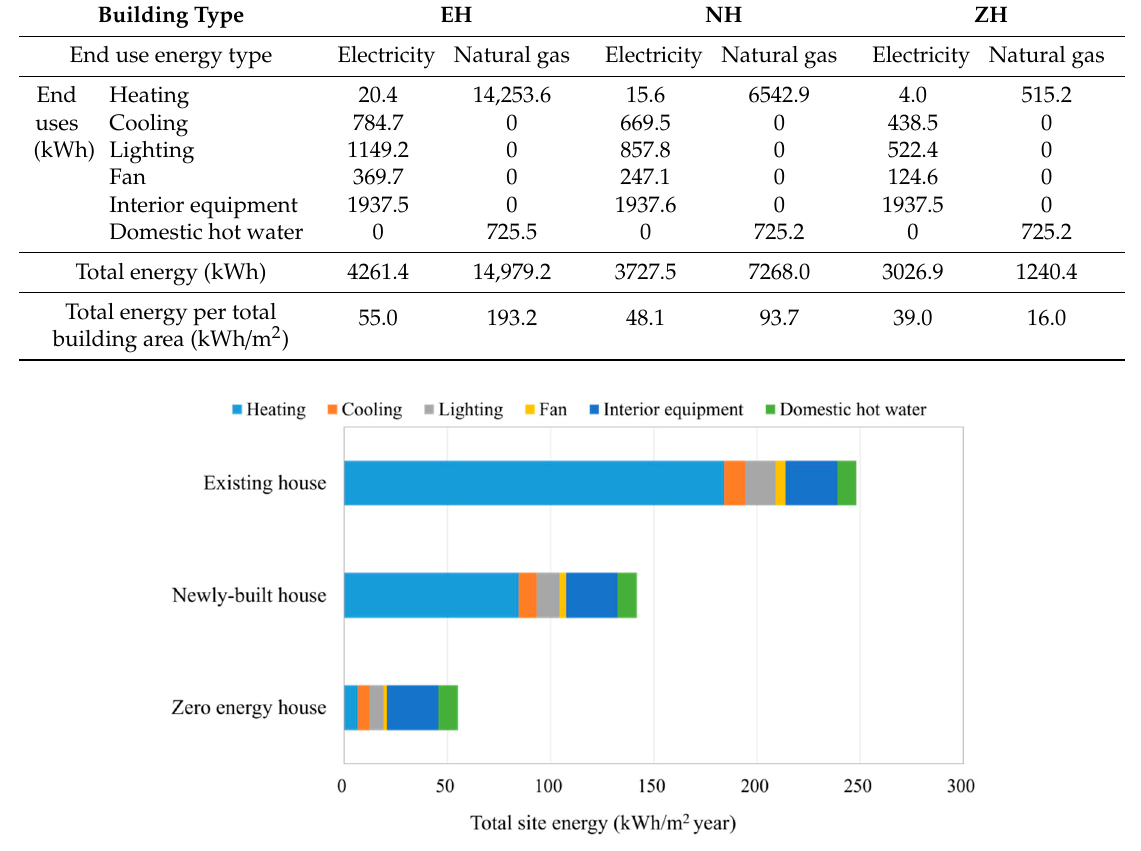
Table 11. Annual energy consumption by end uses.